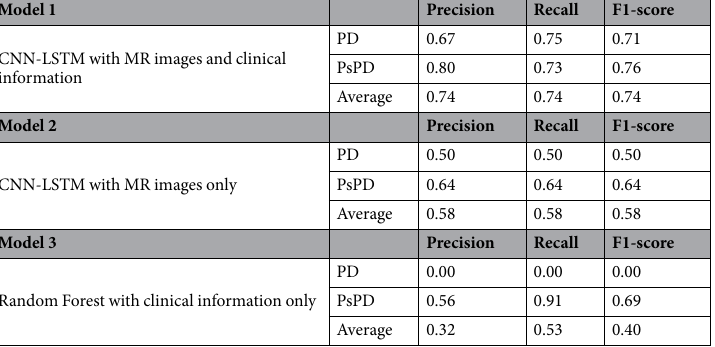
Table 2. Summary of Result and Model Comparison. Abbreviations: PD, progressive disease; PsPD, pseudoprogression; CNN, convolutional neural network; LSTM, long short-term